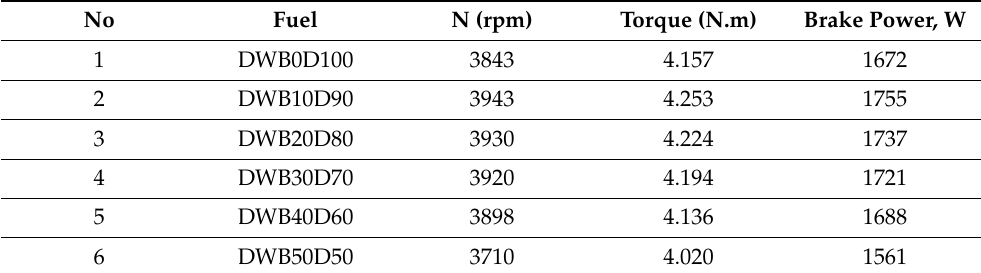
Break specific fuel consumption (BSFC) is calculated by Equation (9):